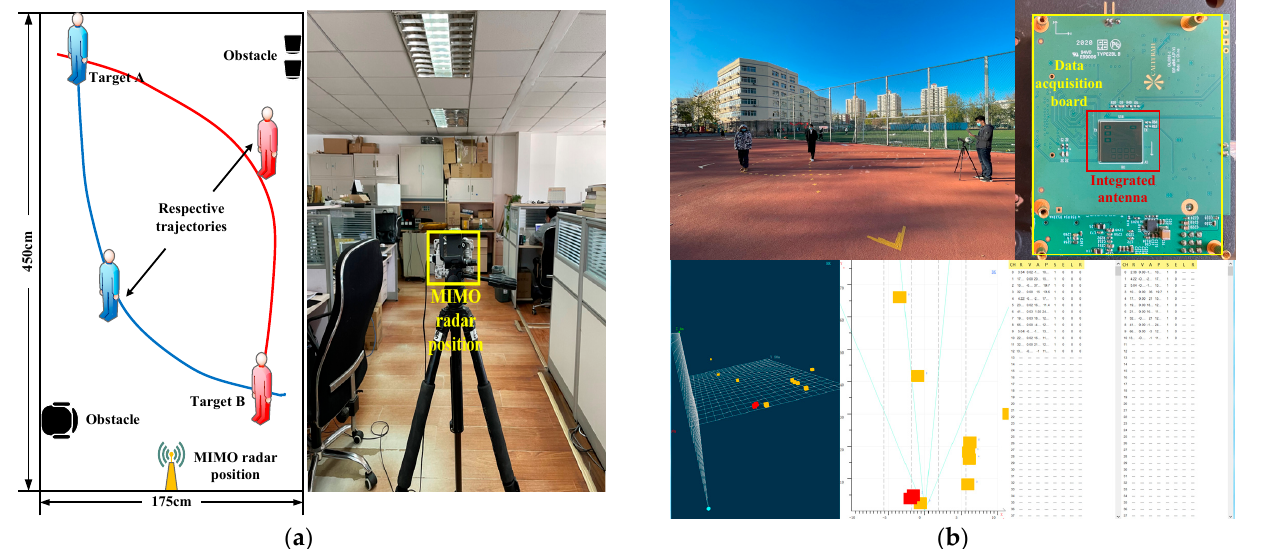
Figure 7. Real data acquisition scenes. ( a ) Indoor scene. ( b ) Outdoor scene. Table 2. MIMO radar parameters.